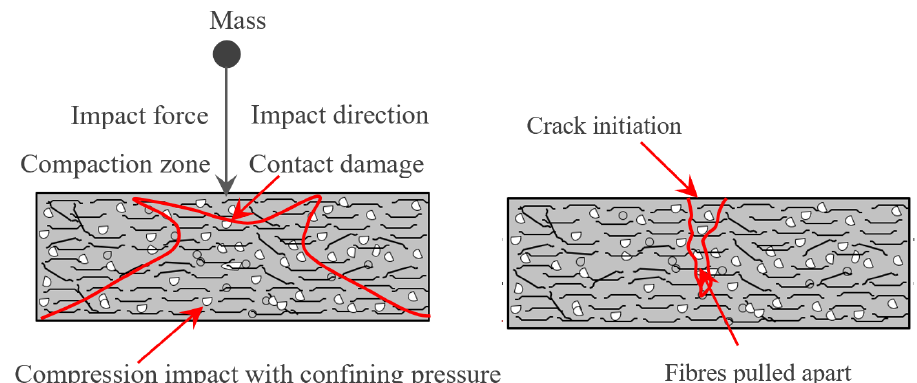
Figure 10. Failure mechanism under impact